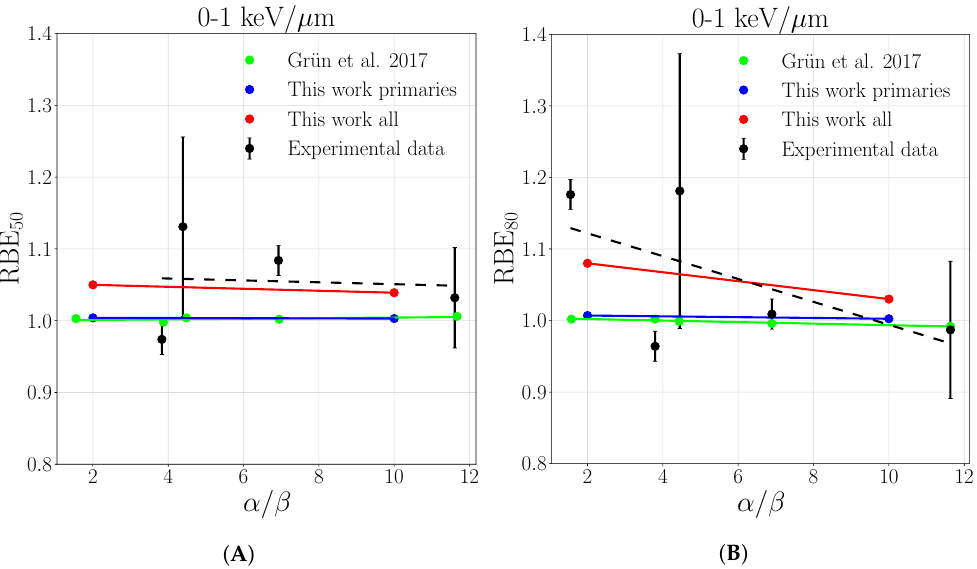
Figure 9. RBE 50 ( A ) and RBE 80 ( B ) as a function of α / β ratio evaluated in LET range of 0–1 keV/µm. Solid lines report linear regressions for the purpose to guide the reading. Experimental data from Grün et al. [10], the legend stands for both panels.